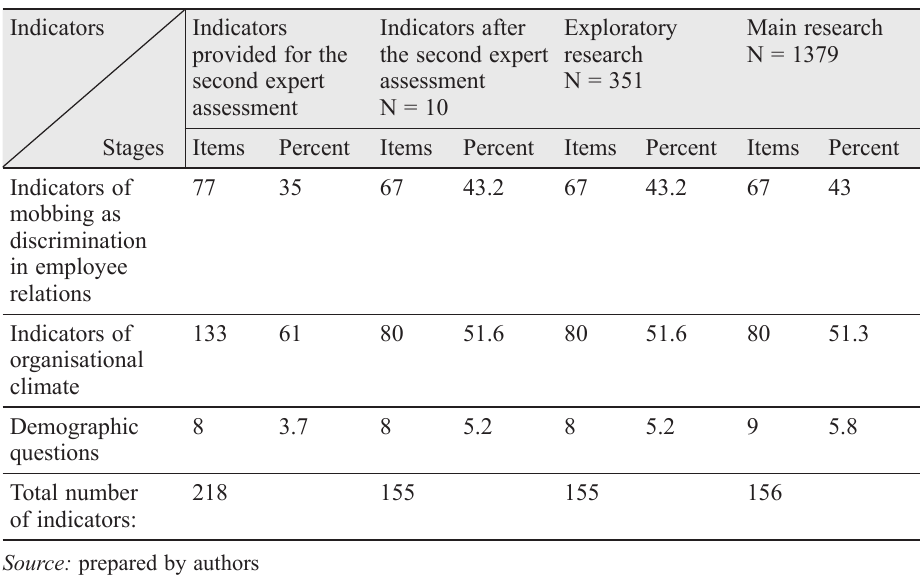
Table 5. The change in the number of indicators of the